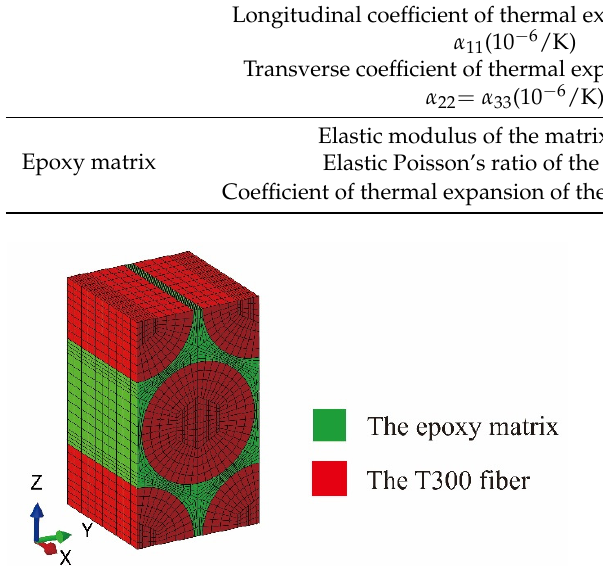
Table 7. The volume fraction parameters of the T300/Epoxy PWF composite.